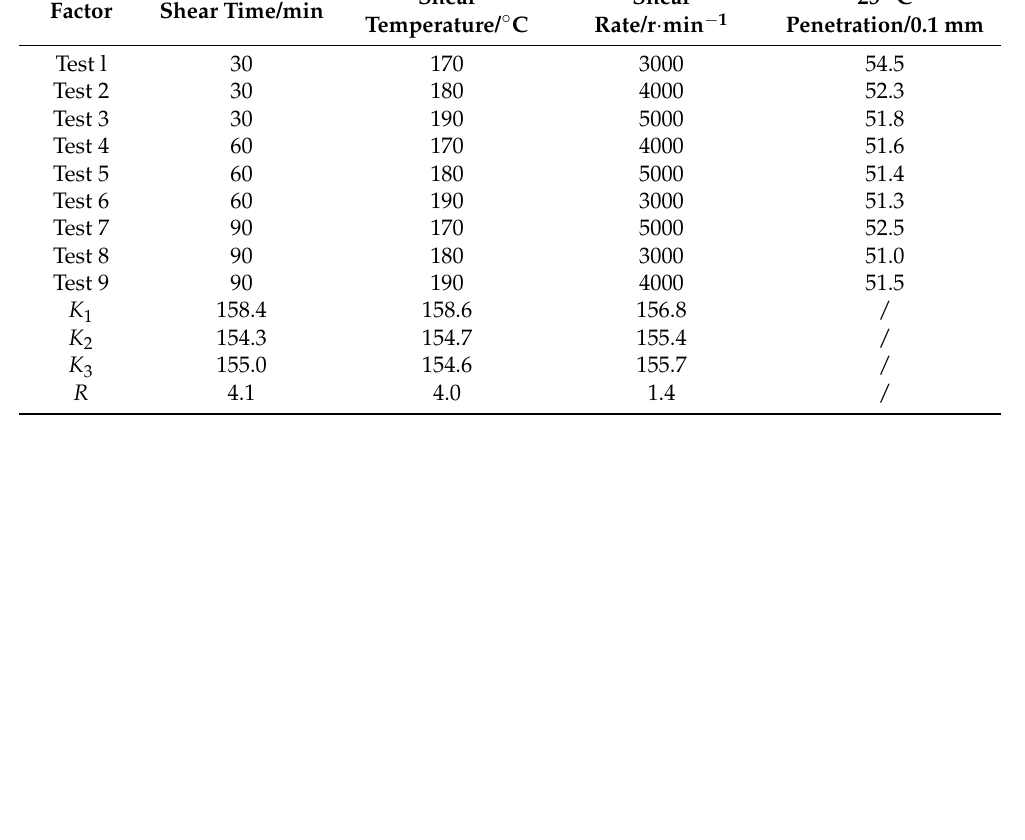
Table 11. Calculation results of penetration test R and K values of PP modified asphalt. Factor Shear